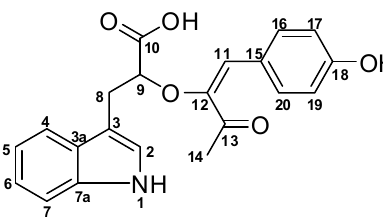
Figure 1. Structure of 2-(1-(4-hydroxyphenyl)-3-oxobut-1-en-2-yloxy)-3-(1 H -indol-3-yl)propanoic acid ( 1 ).